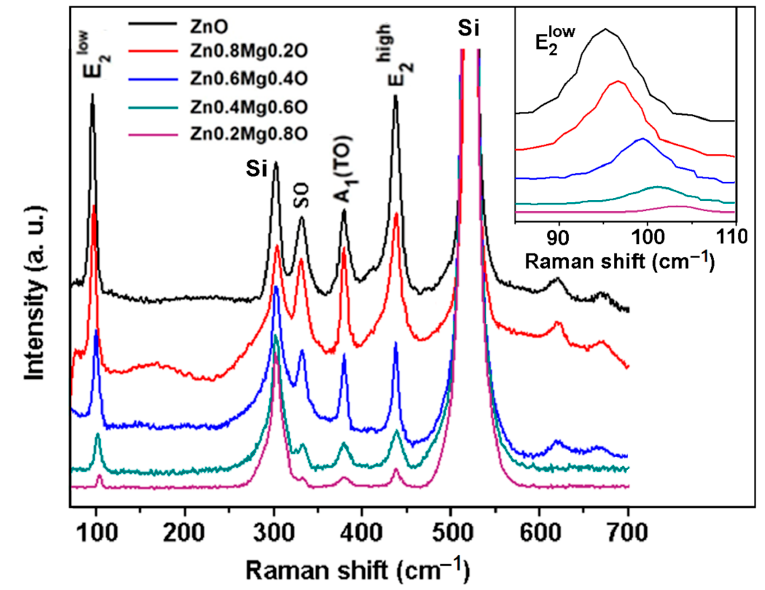
Figure 8. RS spectra of Zn 1 − x Mg x O films deposited by aerosol spray pyrolysis. Evolution of the E 2low mode with increasing x value is shown in the inset.